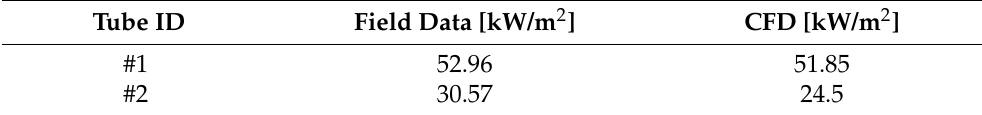
Table 12. Comparison between heat fluxes for field datasheet and CFD model in First Tubes.